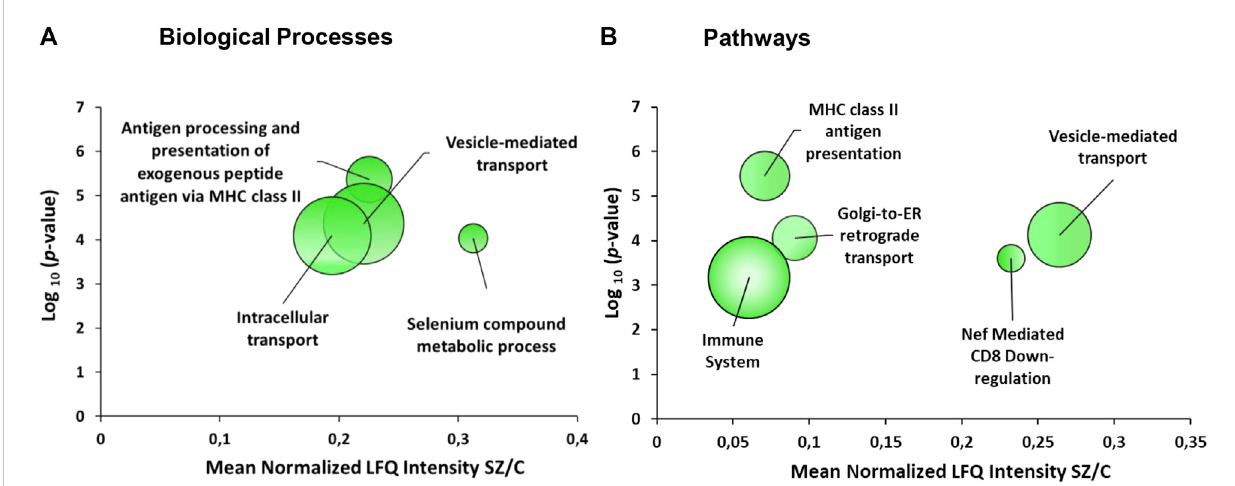
FIGURE 3 Enrichment analyses from the dorsolateral prefrontal cortex proteome in chronic schizophrenia. The bubble chart shows enriched categories from 43 altered proteins in schizophrenia. (A) Non-redundant enriched biological processes categories were: antigen processing and presentation of exogenous peptide antigen via MHC class II (GO:0019886), vesicle-mediated transport (GO:0016192), intracellular transport (GO:0046907) and selenium compound metabolic process (GO:0001887). (B) The enriched pathway categories in schizophrenia were: MHC class II antigen presentation (R-HSA-2132295), vesicle-mediated transport (R-HSA-5653656), Golgi-to-ER retrograde transport (R-HSA-8856688), Nef-mediated CD8 downregulation (R-HSA-182218) and immune system (R-HSA-168256). The X -axes show the mean of normalized LFQ intensity in schizophrenia relative to the control group for all the proteins that belonged to each category. The Y -axes show the -log 10 enrichment p -value. The bubble size is directly proportional to the number of proteins represented in each enriched category, biological process or pathway. The green color represents downregulated proteins. SZ , schizophrenia; C , control; LFQ , label free quanti fi